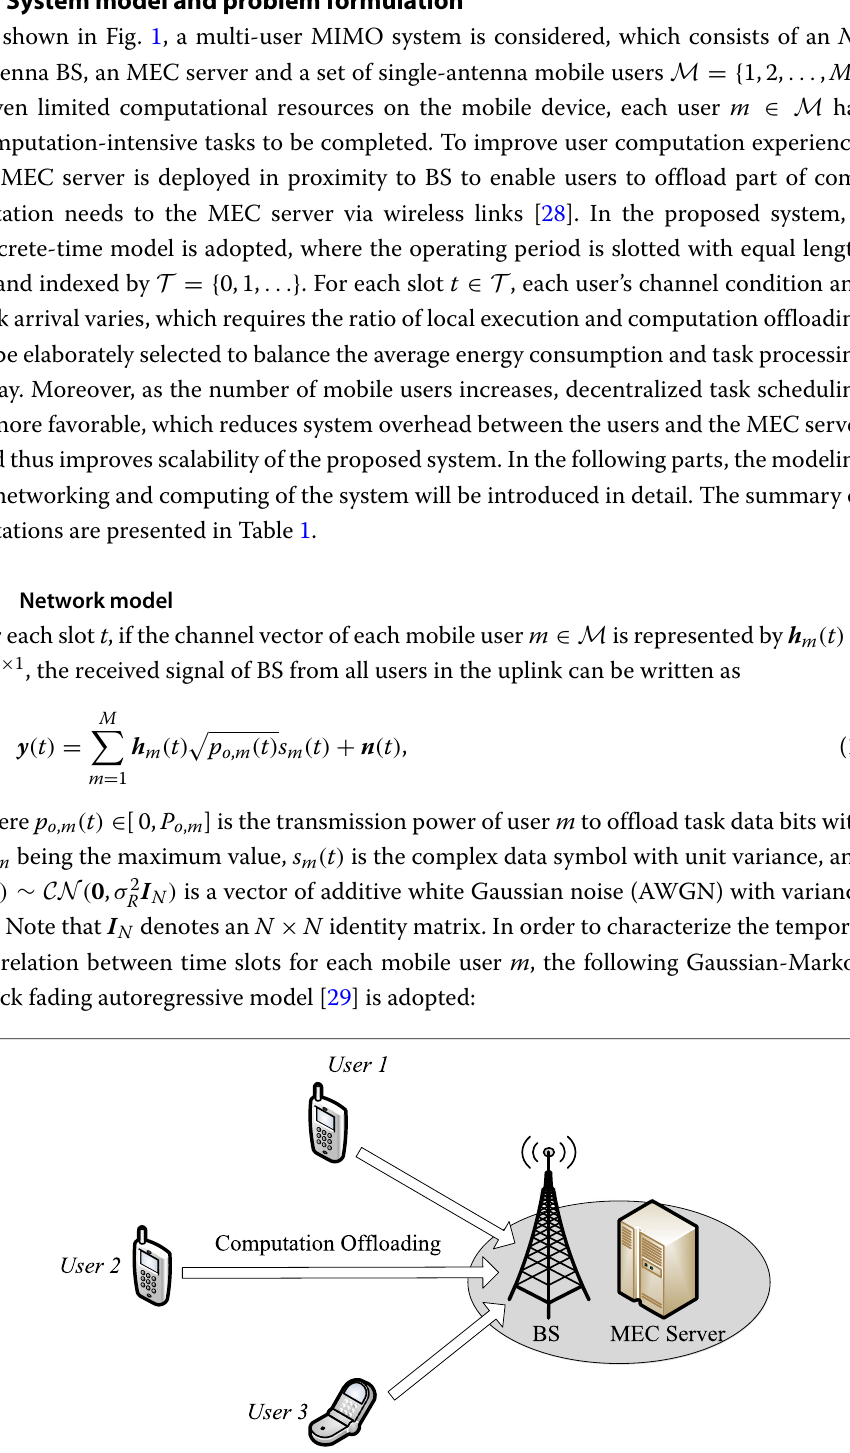
Fig. 1 Computation offloading in an MEC enabled multi-user MIMO